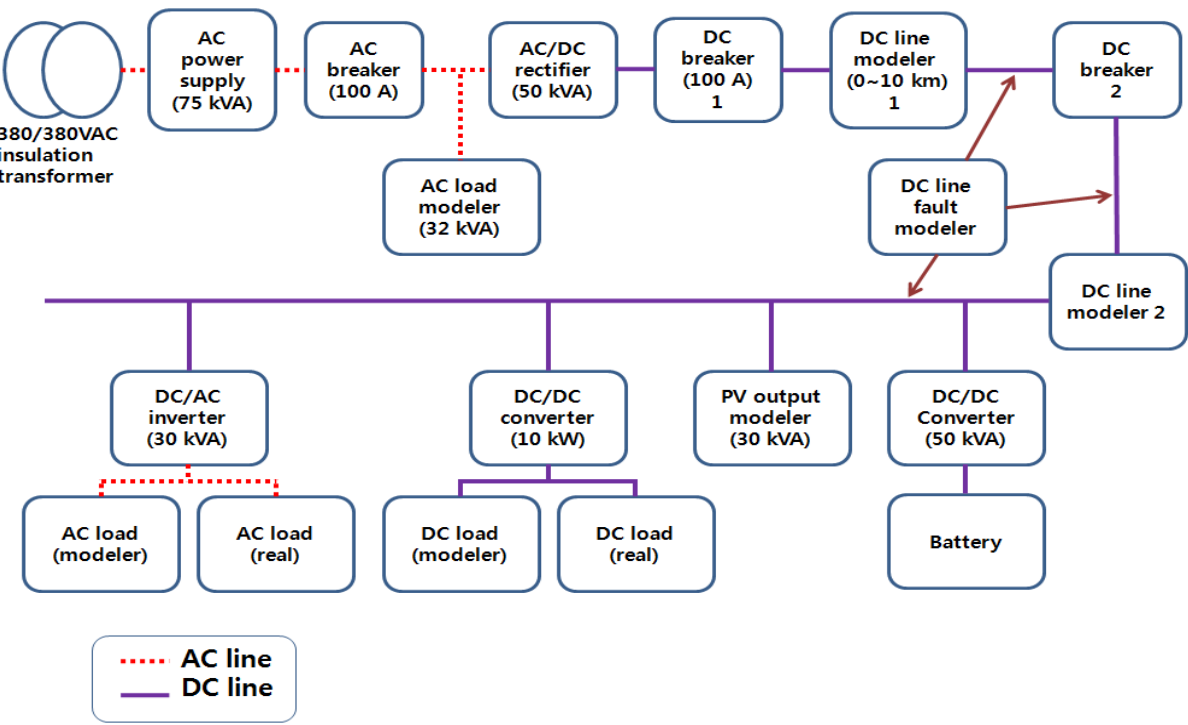
Figure 2. Overall configuration of LVDC